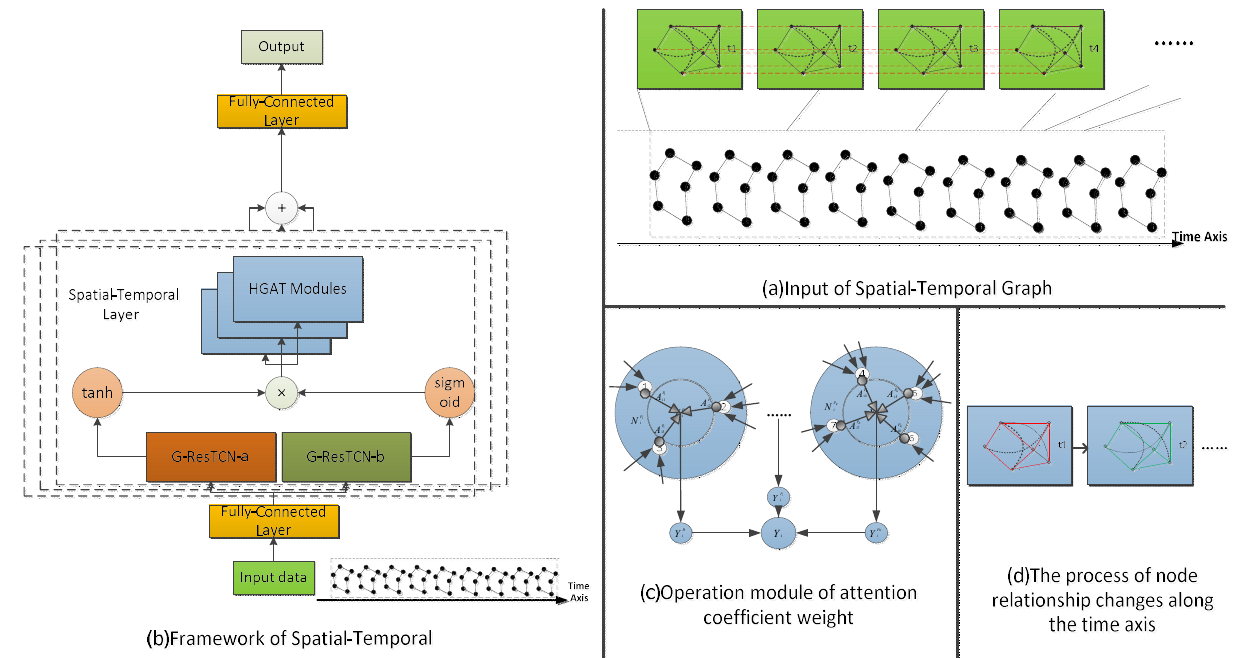
Figure 1. HGA-ResTCN framework: ( a ) An example of input for our spatial-temporal graph, the purpose is to show the relationship between different graph nodes, and use the traffic information features on the graph as input to our model. ( b ) For our time-space framework, input data X , including map information features and f traffic features observed by each sensor (such as traffic speed, occupancy rate, etc.); Among them, the use of two parallel gating mechanisms is to expand the receiving domain of the network, thereby enhancing the performance of the model to extract long-term dependencies between traffic data; and each layer model of the stacked heterogeneous graph attention module will receive independent training and jointly extract the spatial dependence of mutual influence between graph nodes. The two parts together constitute the spatial-temporal layer of the model, which is used to extract the spatial-temporal characteristics of traffic data. ( c ) is the specific representation module of the change of the attention weight coefficient of the heterogeneous graph attention module. ( d ) is the process diagram of the node relationship changing over time. The thickness of the dashed line and the color of the edge in the figure indicate the change process of the node relationship.